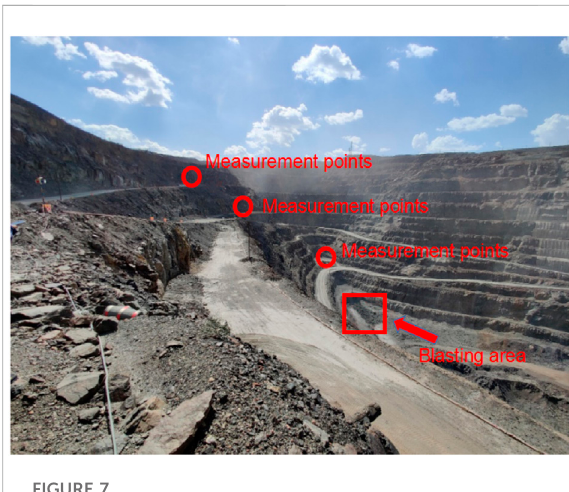
FIGURE 7 Blasting vibration measurement point